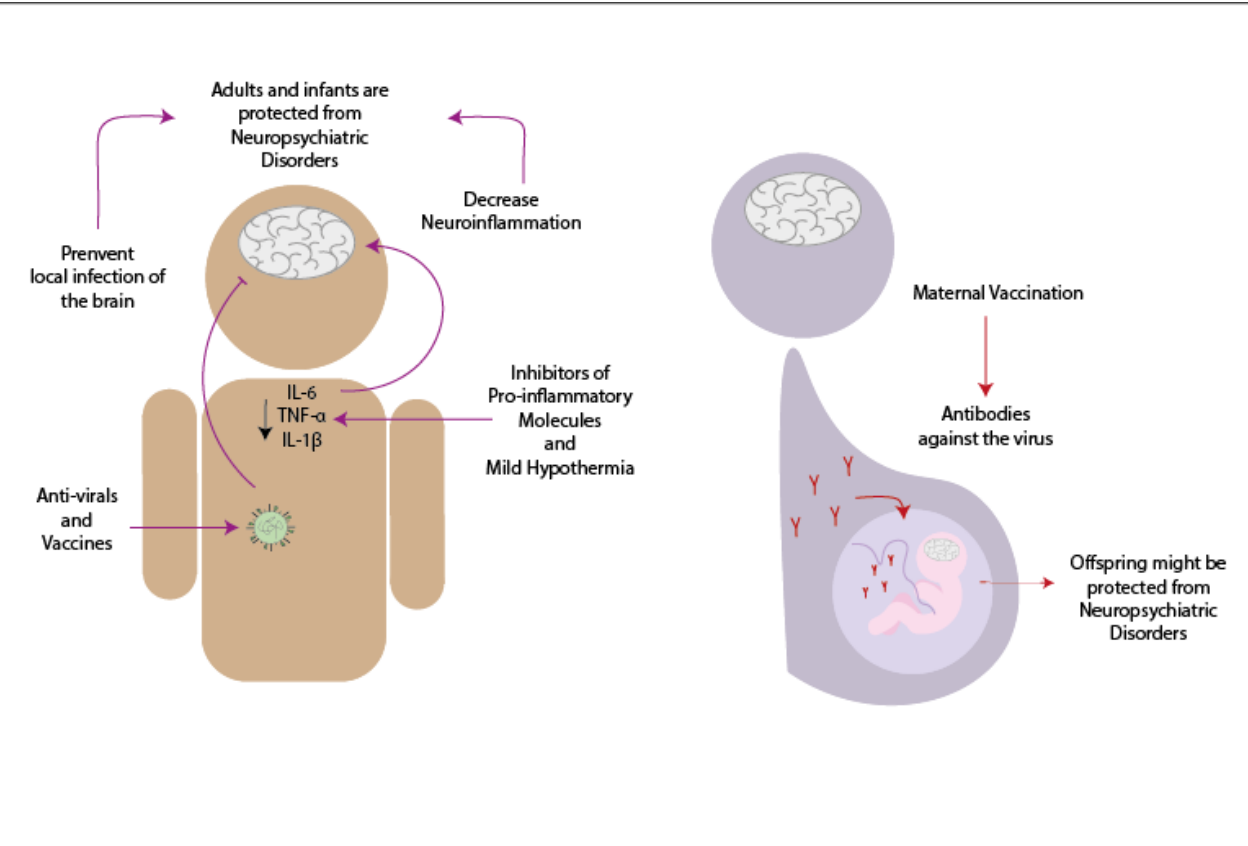
Figure 4. Possible treatments to prevent neurologic consequences in patients infected by respiratory viruses. Adults and infants that present diverse neuropsychiatric disorders can be decreased using antivirals drugs, which will prevent the brain′s local infection and therefore protect from further consequences. Additionally, the use of inhibitors of pro-inflammatory molecules and mild hypothermia can decrease the secretion of pro-inflammatory molecules, and as a result, decrease neuroinflammation. The use of vaccines might protect from developing neuropsychiatric disorders in adults, infants, and offspring due to the maternal vaccination.